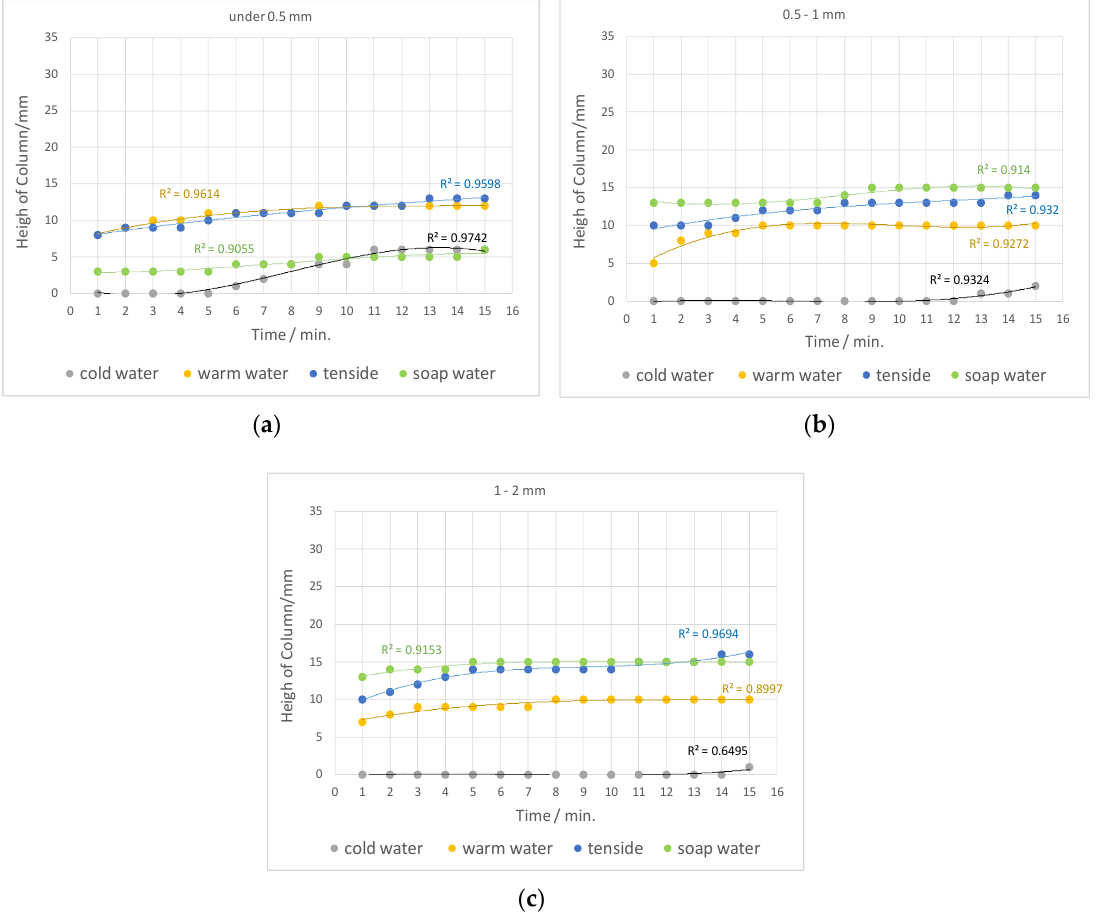
Figure 8. Wetting of pine sawdust at granulometric compositions: ( a ) Under 0.5 mm; ( b ) 0.5–1 mm; ( c ) 1–2 mm.